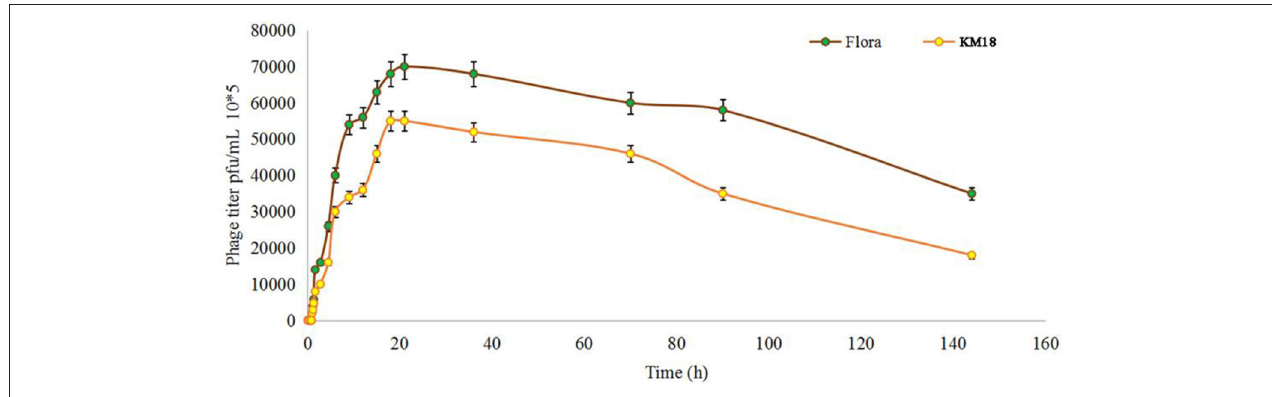
FIGURE 3 | Population dynamics of phages KM18 and Flora incubated with E. coli BL21.